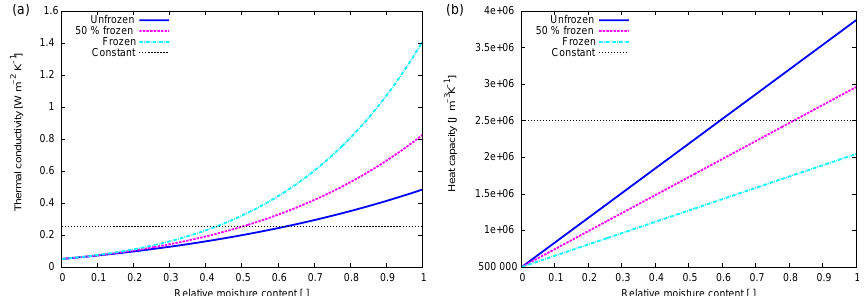
Figure 2. Dependence of (a) thermal conductivity and (b) heat capacity of the bryophyte and lichen cover on relative moisture content. The solid blue curves show the relation between thermal properties and moisture content for liquid water, the magenta dashed curves correspond to a mixture of 50% liquid and 50% frozen water and the light blue dashed-dotted curves correspond to frozen water. The black dotted lines show the thermal properties of the organic layer from the previous model version (Ekici et al., 2014) for comparison. They are constant since they do not depend on water